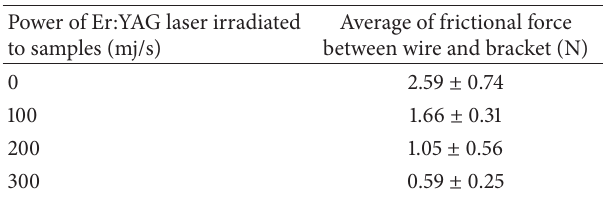
Power of Er:YAG laser